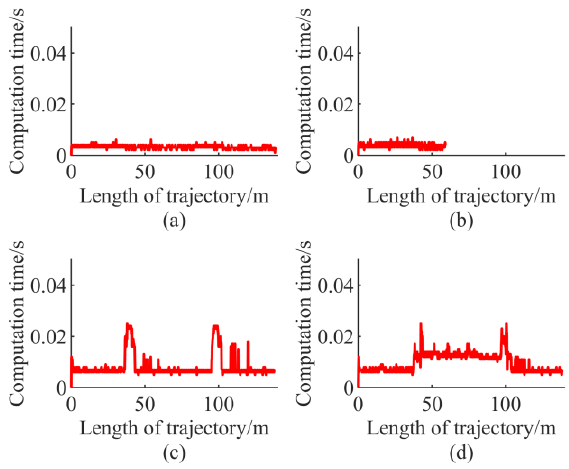
Figure 12. The computation time when velocity is 3 m / s. ( a ) LMPC. ( b ) LEMPC. ( c ) NMPC. ( d ) NEMPC.